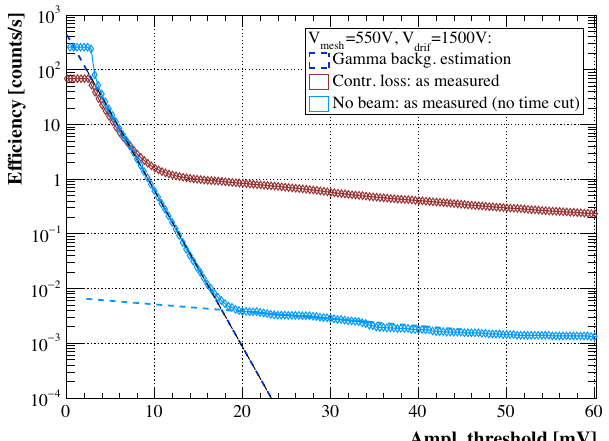
FIG. 14. Relative efficiency extracted from controlled loss (red) and no beam data (blue). Dashed lines indicate exponential functions fitted to the data in order to extract intersection point as the S value. NDT